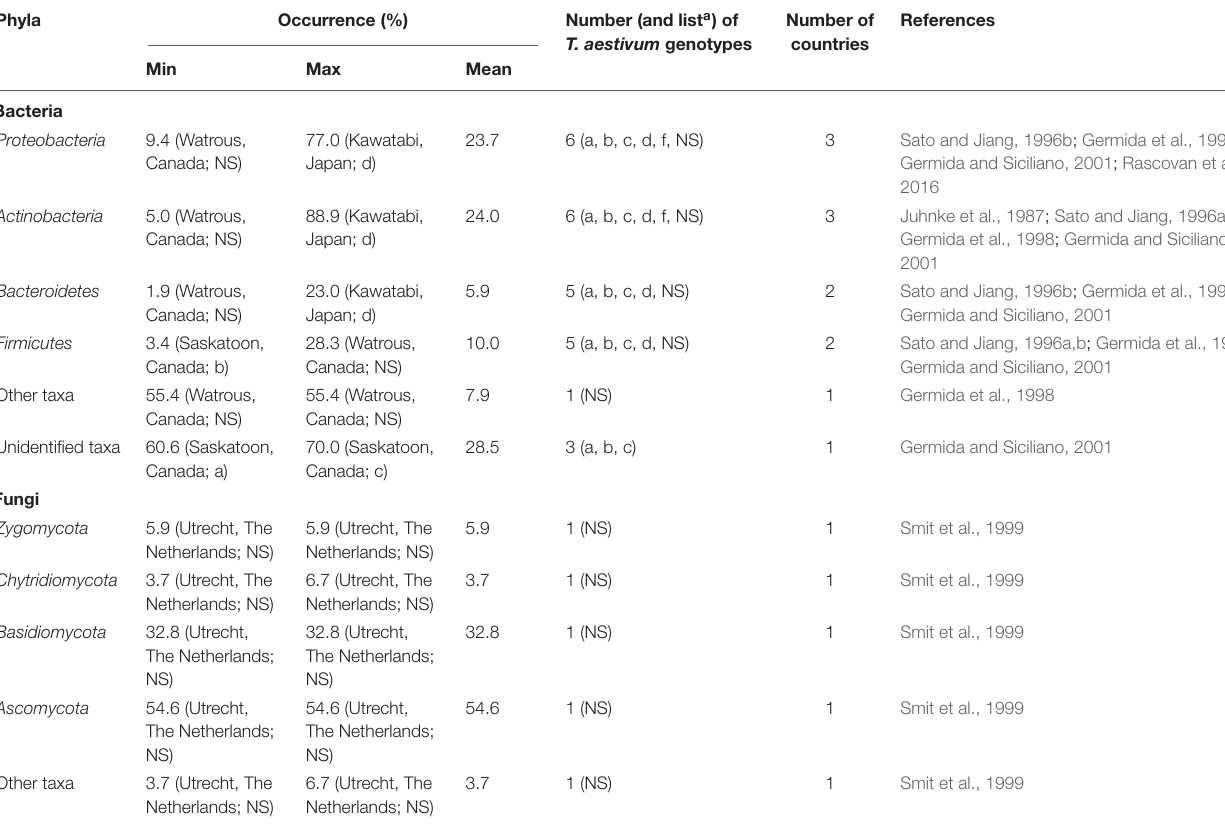
TABLE 2 | Occurrence of phyla in the rhizosphere of T. aestivum , as documented by culture-dependent methods. Phyla Occurrence